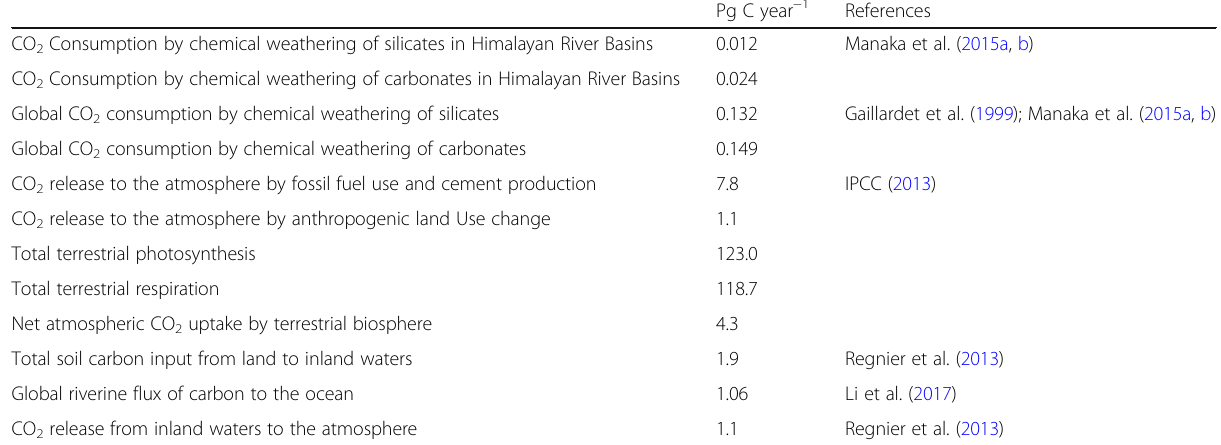
Table 2 Global carbon exchange between land, inland waters, ocean, and atmosphere since the industrial